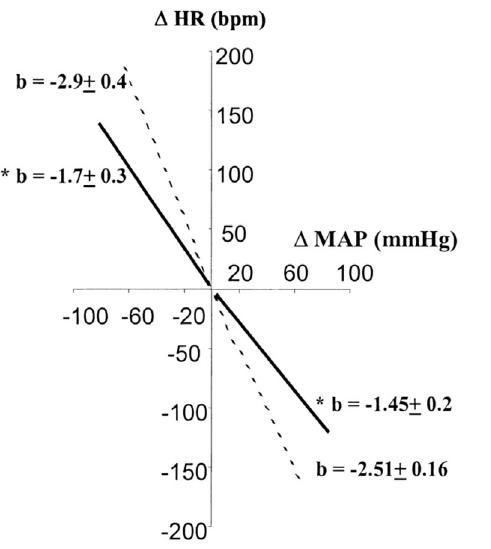
Figure 2 - Baroreflex control of heart rate ( D HR) in young (dashed line) and old (solid line) rats. The HR slopes during increases and decreases in mean arterial pressure ( D MAP) were significantly reduced in old rats as compared with younger specimens. * Significant differences between young and old rats ( P <